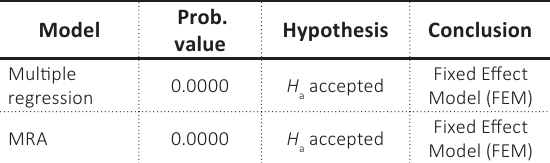
Table 2. Chow test results